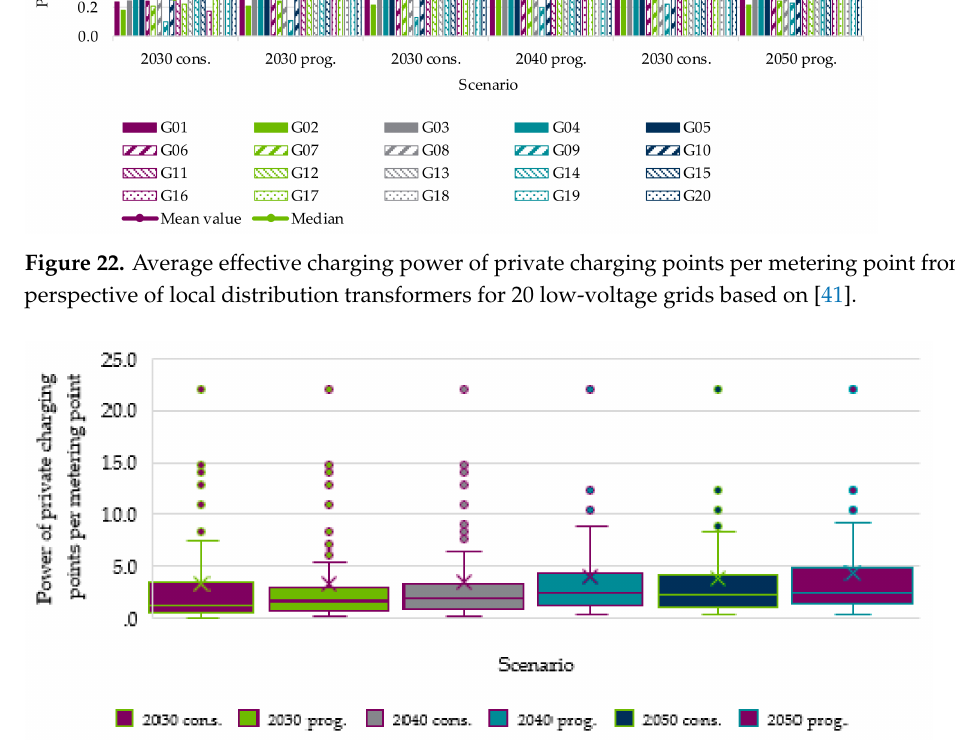
Figure 23. Average effective charging capacity of private charging points per metering point from the perspective of feeders (not including feeders without private charging infrastructure) for 20 low-voltage grids based on [41].